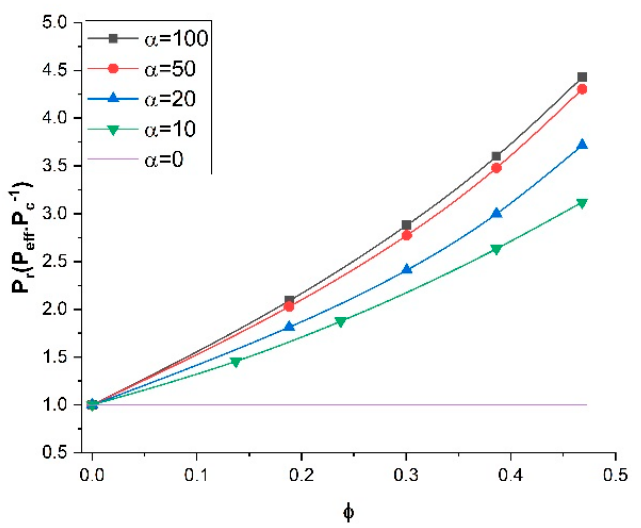
Figure 8. Relative permeability for nanotubes with different length-to-diameter aspect ratios at a permeability ratio P d / P c of 100 and an angle θ of 0 ◦